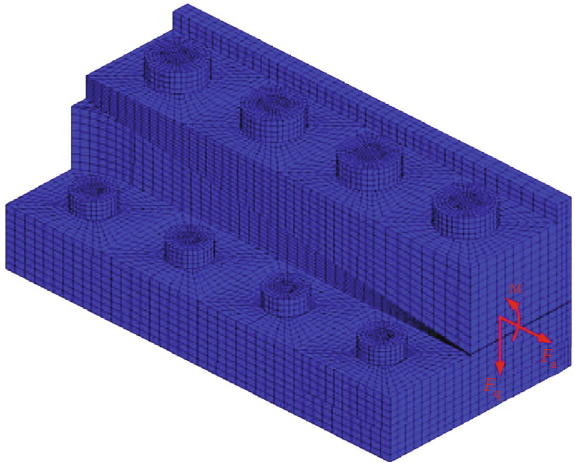
Figure 11: The fi nite element model of the 10th segment model.